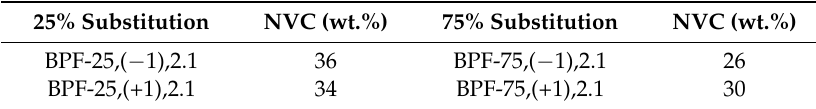
Table 4. NVC of BPF resoles with varying phenol percent substitutions (left to